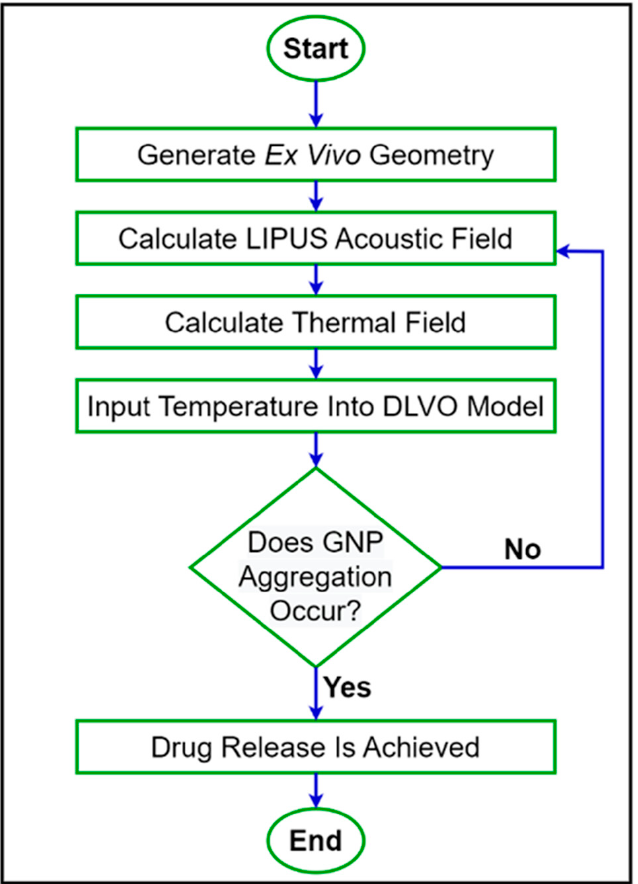
Figure 2. A step-by-step flowchart of the proposed simulation model.